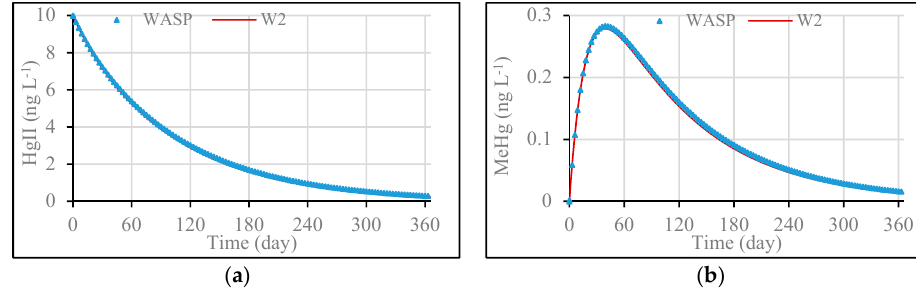
Figure 7. W2 and WASP computed ( a ) HgII and ( b ) MeHg concentrations in the water column.